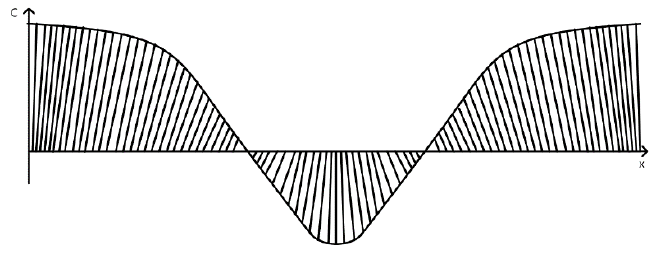
Figure 7. Antiferromagnetic curve of BFO.